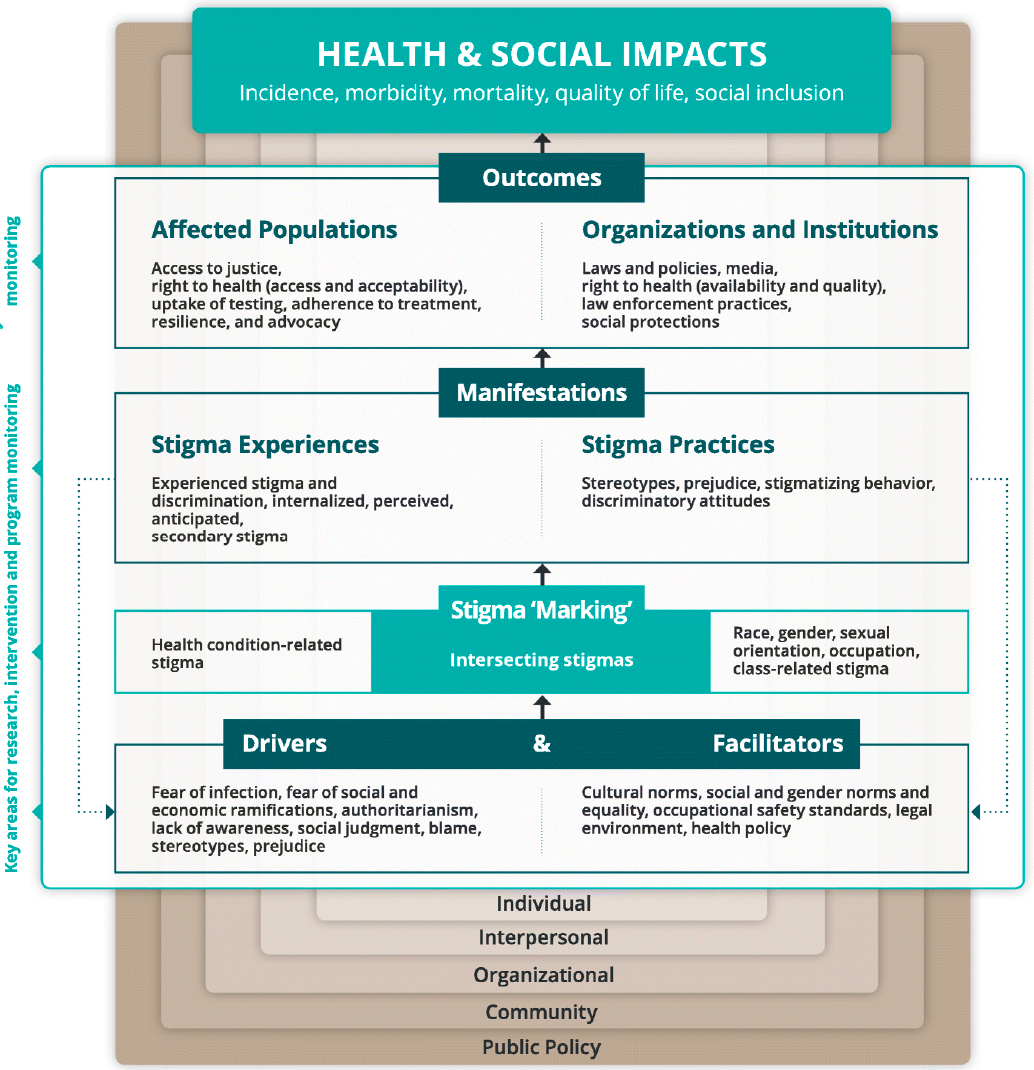
Figure 1. Stangl et al.’s (2019) Health Stigma and Discrimination Framework